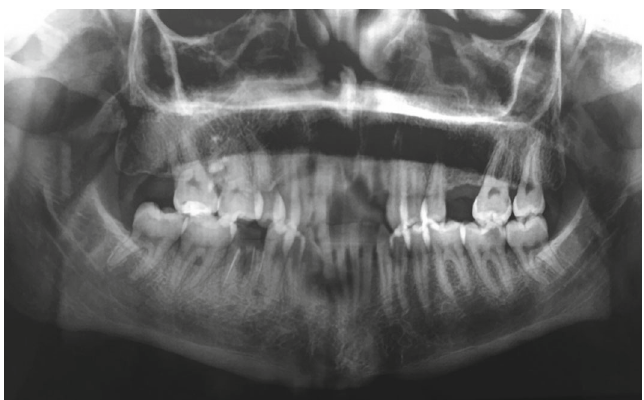
Figure 3: Preoperative panoramic radiograph showing empty sockets of 11, 21, and 22. No sign of fracture or contusion of the alveolar sockets.